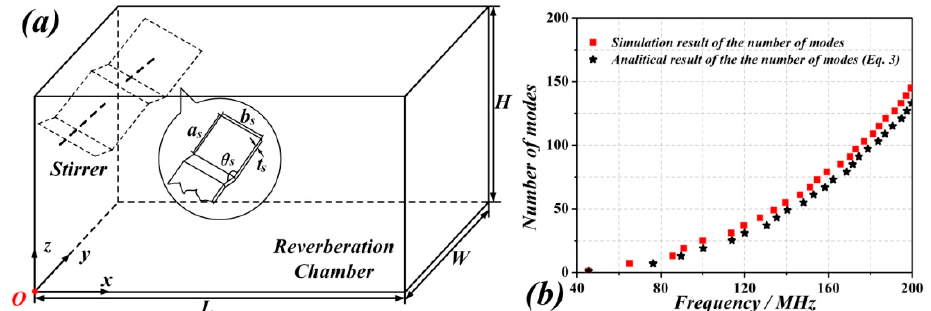
Figure 1. ( a ) Sketch of the metallic RC with mechanical stirrer made of four metallic sheets (PEC) with a s = 1049.8 mm, b s = 799 mm, t s = 2 mm and θ s = 119°. The coordinate of the mechanical stirrer is (740 mm, 400 mm, 3000 mm). ( b ) Comparison of the number of modes as a function of frequency inferred from simulation and analytically.